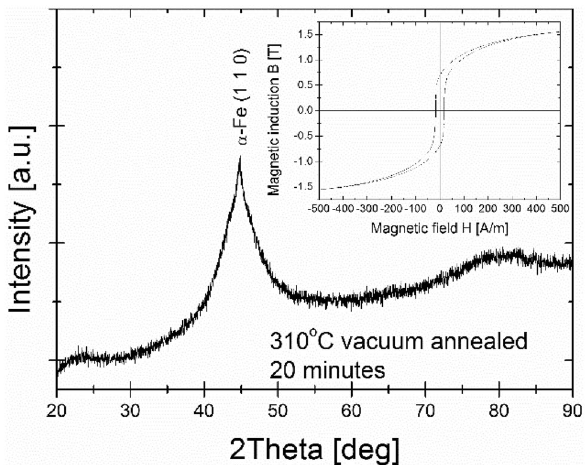
Figure 5. X-ray diffraction pattern and B-H hysteresis loop as the figure inset of conventionally vacuum annealed sample at 310 °C for 20